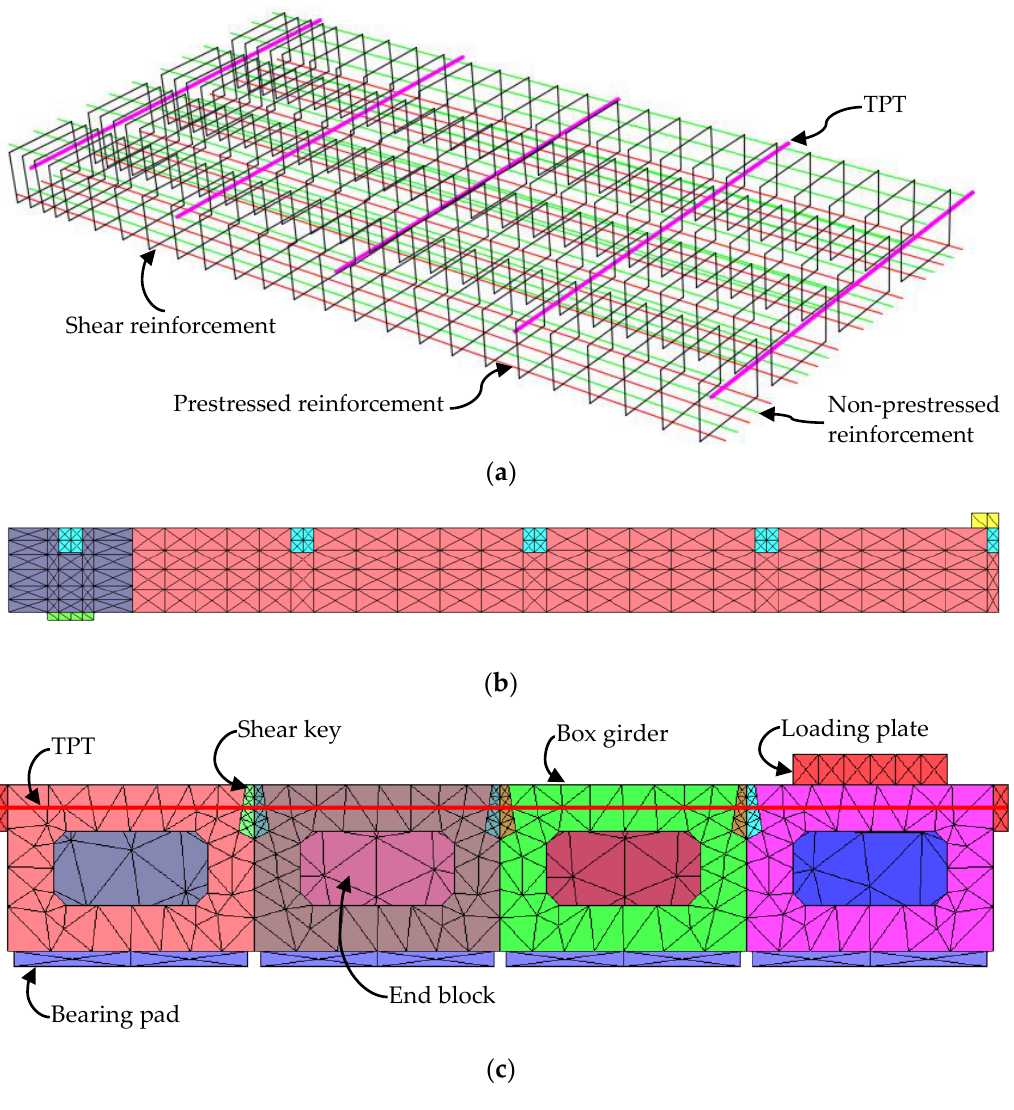
Figure 4. FEM and reinforcement configuration of the bridge model): ( a ) discrete reinforcement, ( b ) mesh discretization in longitudinal direction, and ( c ) mesh discretization in transverse direction.